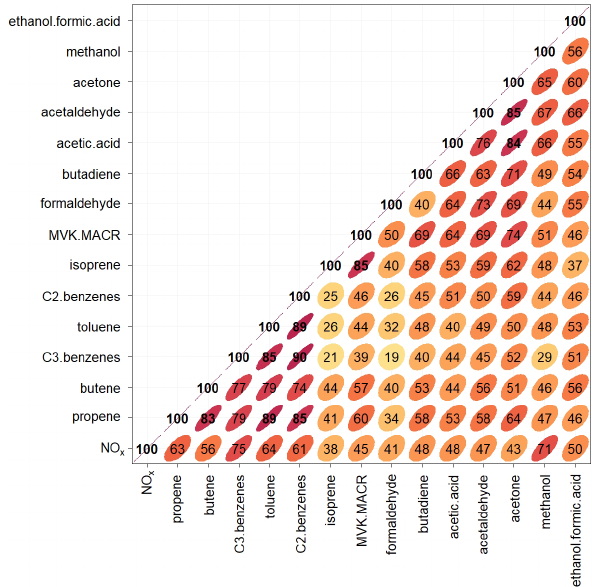
Figure 8. Correlation plot showing the relationship between the fluxes of all identified compounds that contribute more than 0.75% to the total measured VOC flux in the summer measurement cam- paign and the NO x flux. Numbers and colours represent the % R 2 value of each